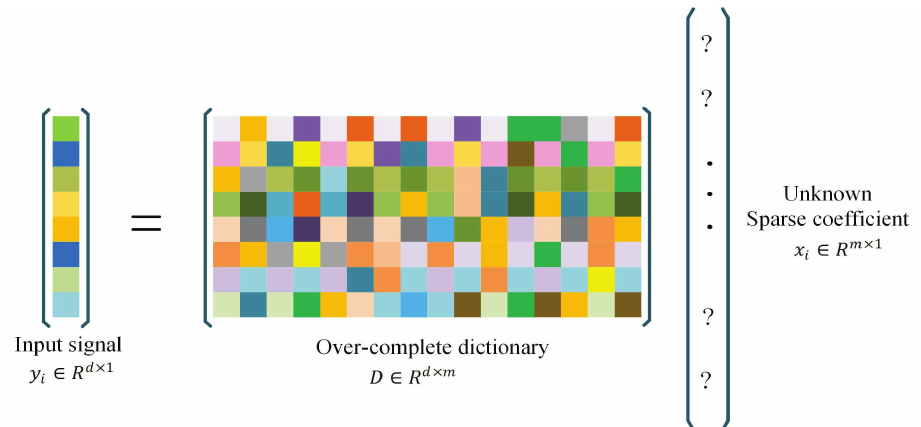
Figure 3. Sparse coding of a signal y i .